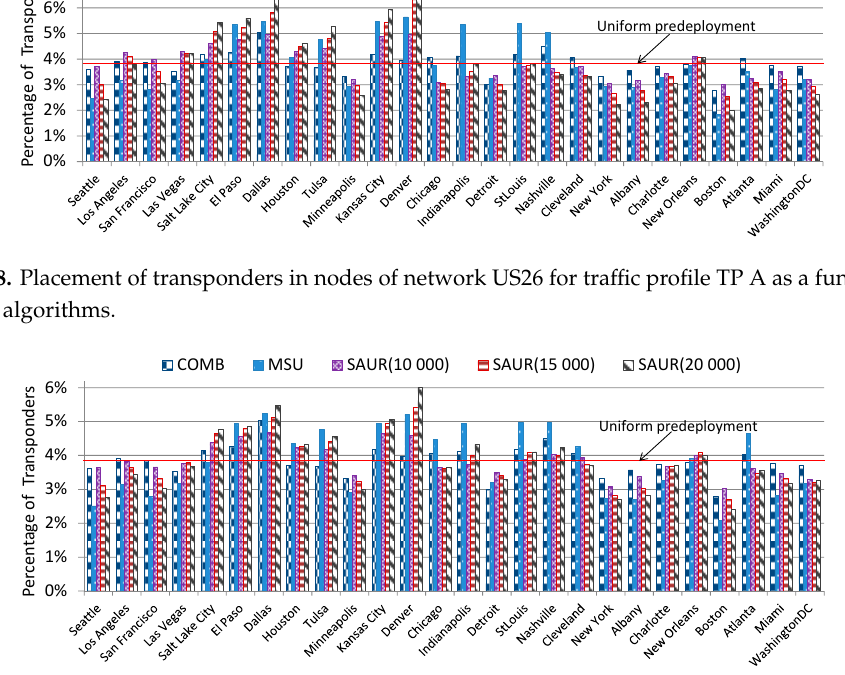
Figure 10. Placement of transponders in nodes of network US26 for traffic profile TP C as a function of various algorithms. Moreover, it should be noted that SAUR placed much more transponders in some nodes when the budget was 20,000 devices compared to when the budget was 10,000 devices. The largest such differences were observed again for the traffic profile TPA and for nodes located in the center of the US. Once again it can be explained by the fact that with the larger budget of transponders, more regeneration points are possible (see Figures 11–13). These regeneration points are mostly used for longer lightpaths such as the east cost–west coast traffic which allows to change less spectral efficient modulation formats to more efficient modulation formats and thus consume less resources that can be next utilized for other lightpaths. Finally, more traffic can be accepted in the network. In Figures 11–13, we report more detailed results for the same cases such as in Figures 8–10. Each figure shows the average results on utilization of spectrum and transponders (bars) and average number of regeneration points (points). The main observation is that in all cases, the SAUR method provided the best (highest) utilization of spectrum and transponders. In other words, the placement of transponders yielded by SAUR allowed to utilize the network resources to the highest extent which, in consequence, allowed to allocate more traffic than the other methods. In terms of